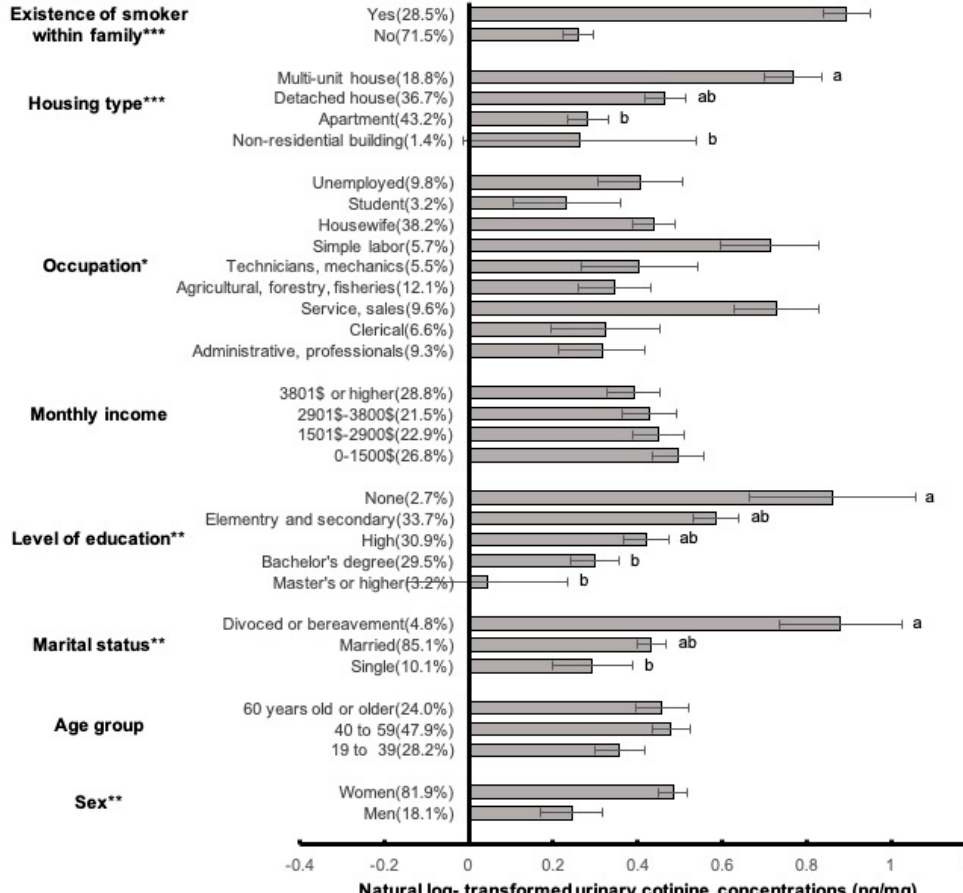
Figure 1. Means and standard errors of log-transformed urinary cotinine concentrations according to socio-demographic factors including sex, age group, marital status, level of education, monthly income, occupation, housing type, and the presence of a smoker within the family. T-test and ANOVA with Scheffe's post-hoc test (a, b). * p < 0.05; ** p < 0.01; *** p < 0.001.